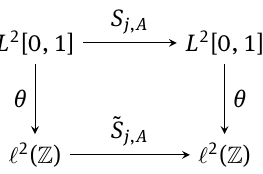
Figure 2: Diagram of the Intertwining of S j , A and ˜ S j , A